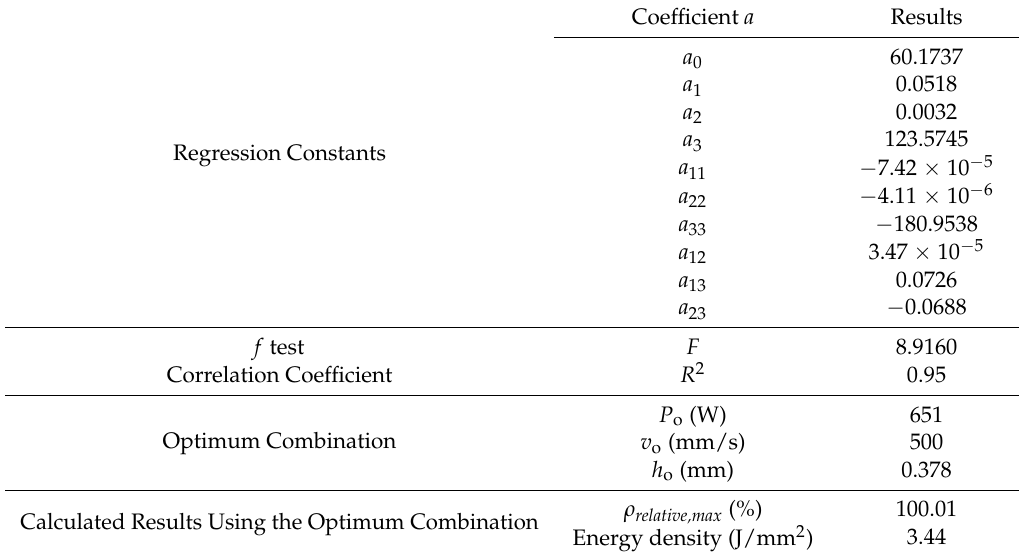
Table 6. The constants of the model, model testing, and the optimized SLM process parameters.